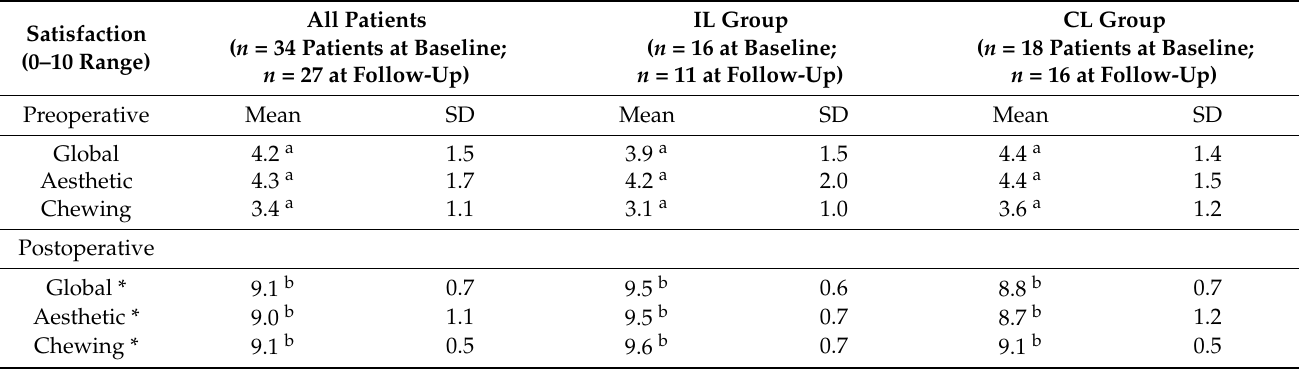
Table 7. Changes in self-rated chewing, aesthetic, and global satisfaction on a 0–10 scale after prosthetic treatments ( n = 34 at baseline; n = 27 at follow-up).